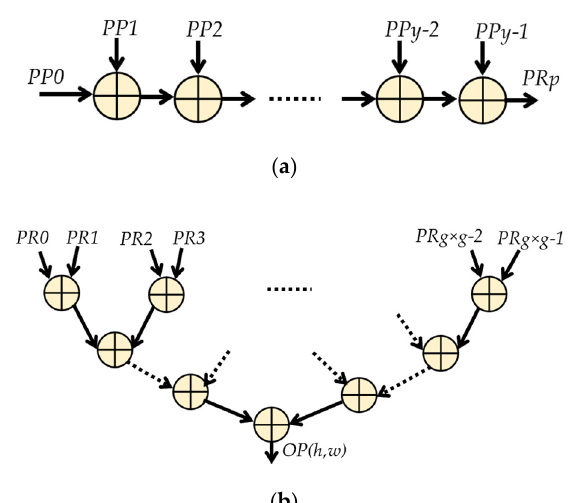
Figure 8. The 2D digital filter adopted in the case study: ( a ) the approximate multiplier; ( b ) the approximate adder tree.